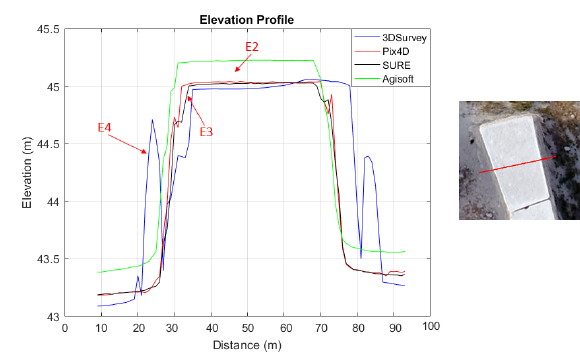
Figure 3. Elevation profiles on DSMs at steep edges